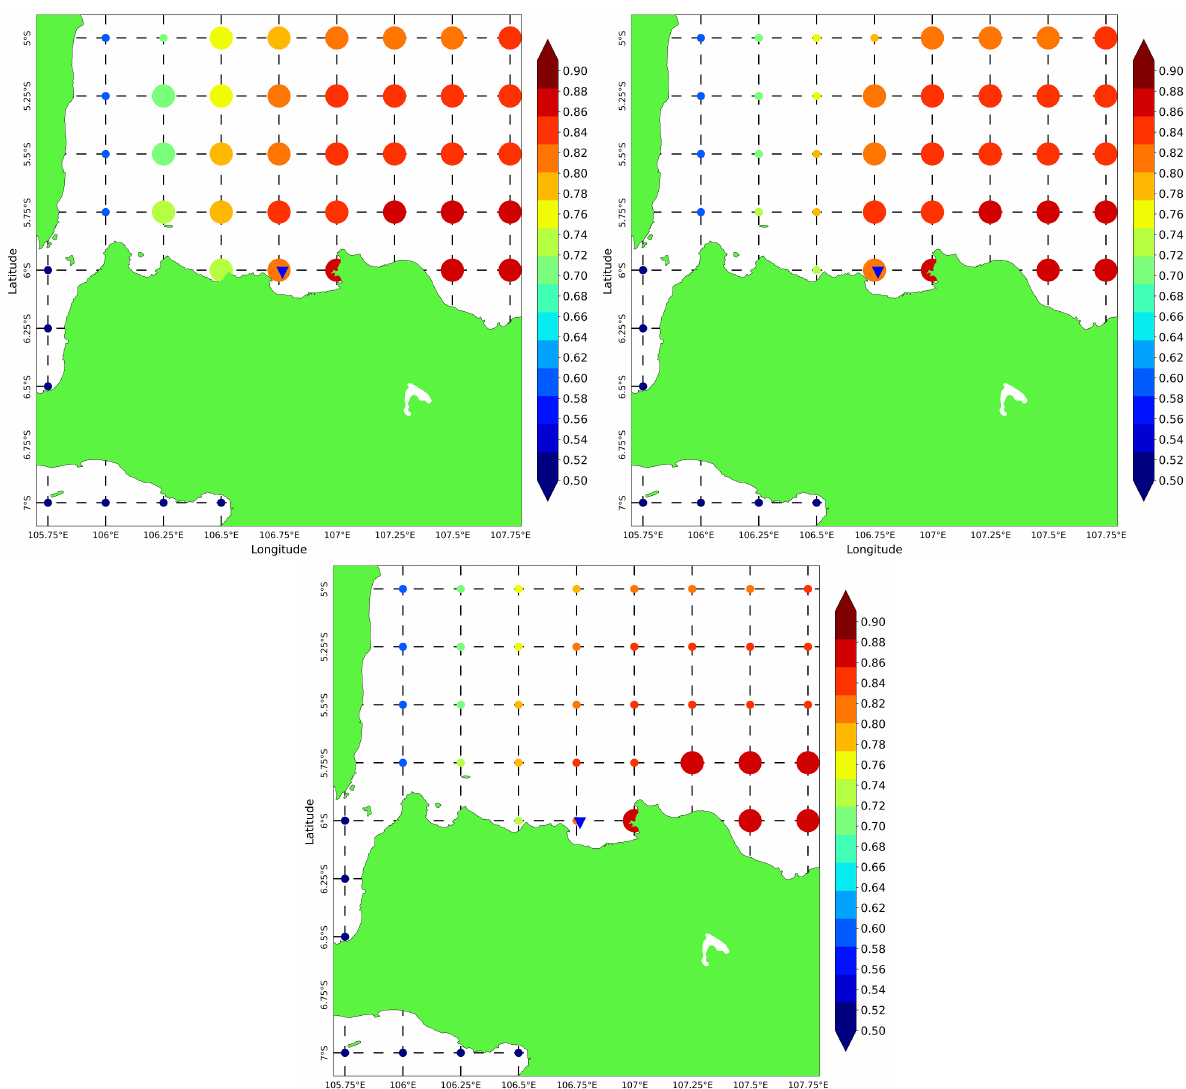
Figure 11. The spatial correlation map at Jakarta Bay was obtained by calculating the correlation coefficient (CC) between Hs at the global grid and Hs at the targeted local domain. Big dots denote CC values: upper left plot for CC values ≥ 0.70, upper right plot for ≥ 0.80, and lower plot for ≥